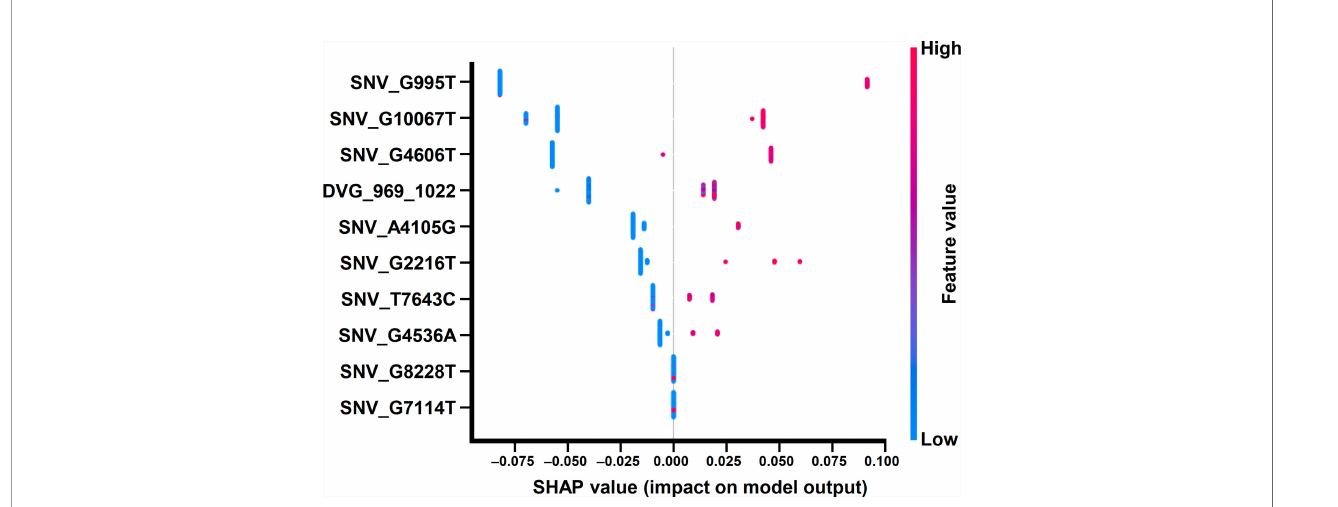
FIGURE 7 | Beeswarm plot of the ML model using SHAP explainer. Beeswarm plot mapping the effects of the indicated features on prognosis outcomes, which assigns a continuous color to the features based on the detection frequency and the number of times each SNV/DVG was